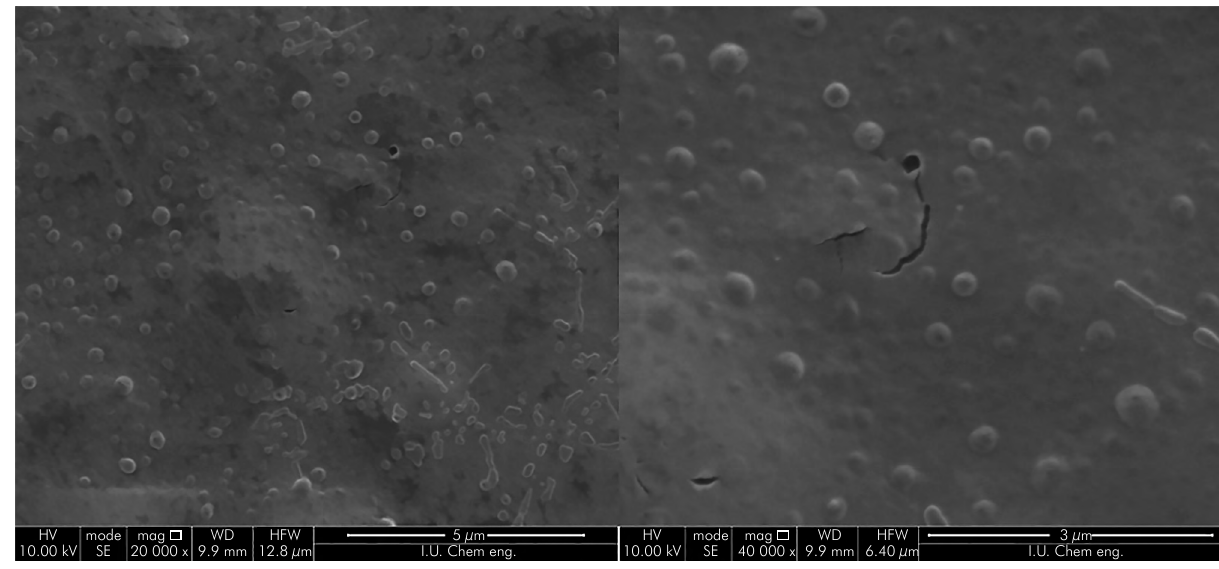
HV 10.00 Figure 1. Morphological characteristics of hPTH-loaded chitosan microspheres using scanning electron microscopy.